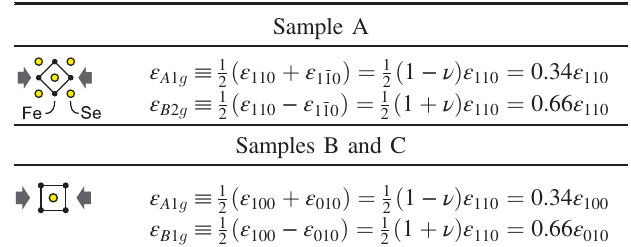
TABLE I. Strain parameters. We take the 1-Fe unit cell, in which the h 100 i directions are Fe-Fe bond directions. Sample A is aligned so that stress is applied along the [110] lattice direction; the strain along this axis, ε 110 , is measured by the displacement sensor integrated into the stress cell. Samples B and C are aligned so that stress is applied along the [100] direction. ν ¼ 0 . 32 is the Poisson ratio of the platform. The graphics illustrate the strain directions. We take the sign convention that ε < 0 denotes